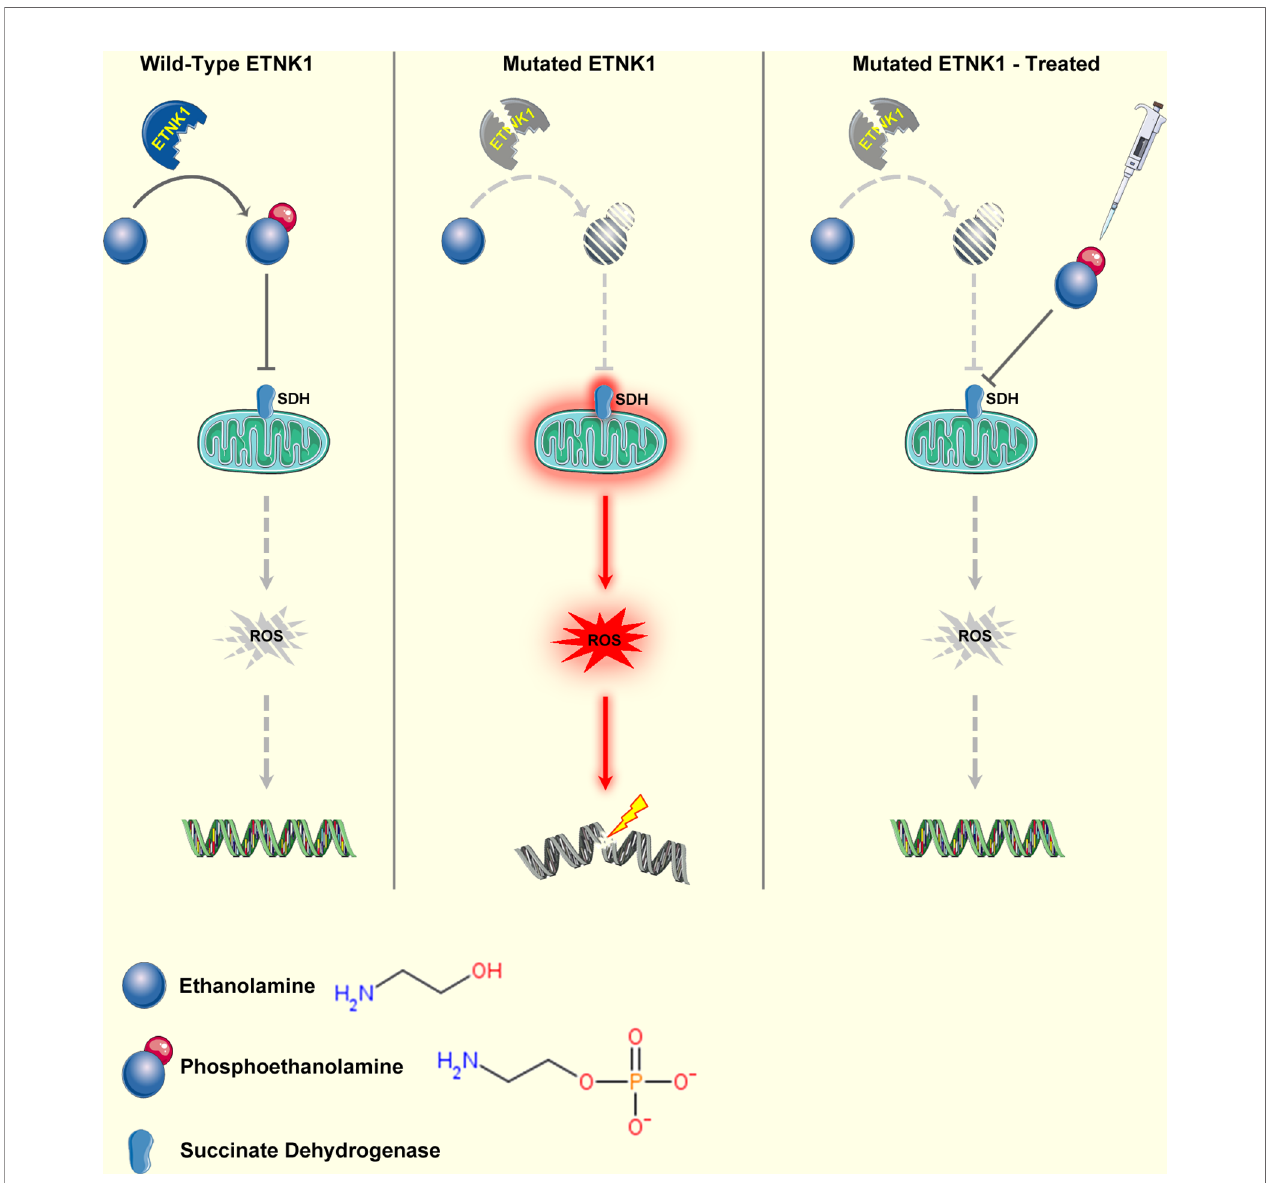
FIGURE 2 | Mechanism of ETNK1 somatic mutations. Left panel: WT ETNK1 phosphorylates ethanolamine, causing the accumulation of phosphoethanolamine. Phosphoethanolamine directly inhibits mitochondrial complex II, also known as succinate dehydrogenase, therefore downmodulating mitochondrial activity and ROS production. Middle panel: mutated ETNK1 causes a decreased production of phosphoethanolamine, which in turn leads to an increased mitochondrial activation, increased ROS production, and DNA damage. Right panel: treatment of ETNK1-mutated cells with exogenous P-Et restores the normal mitochondrial activity through direct suppression of SDH activity, normalization of ROS production, and protection of DNA from ROS-mediated damage. The image was obtained from: Nat Commun. 2020 Nov 23;11(1):5938 under a Creative Commons Attribution 4.0 International License. Elements of the image were obtained from